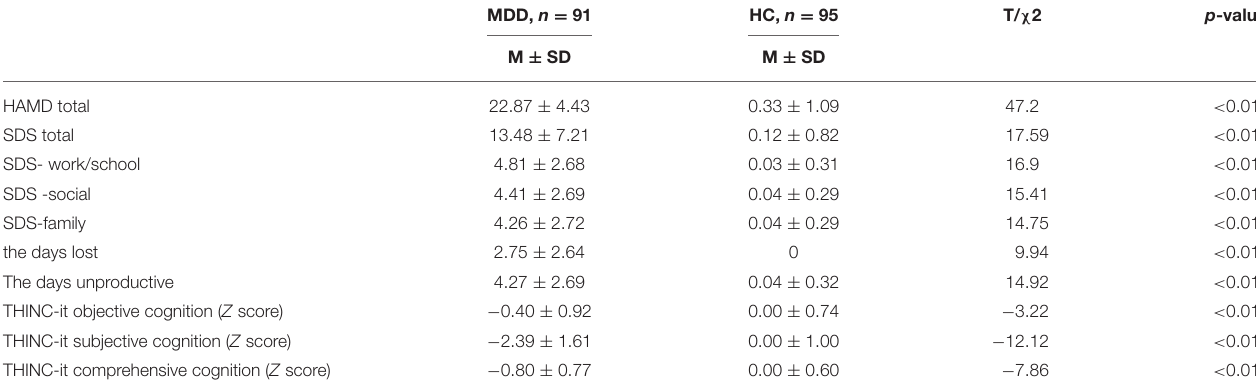
TABLE 2 | Comparison of depression degree, cognitive function and social